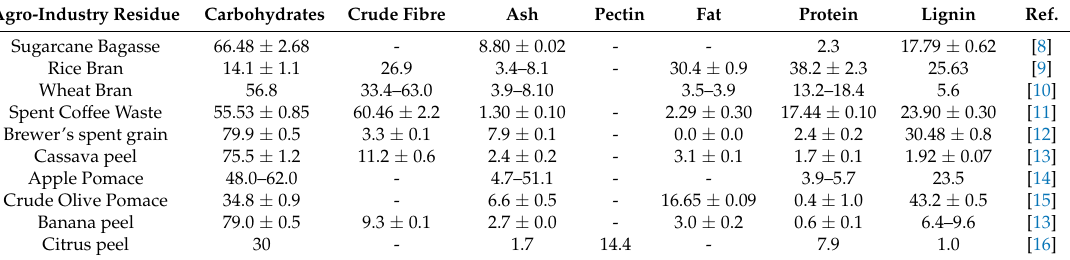
Table 1. Chemical composition (%) of important agro-industry